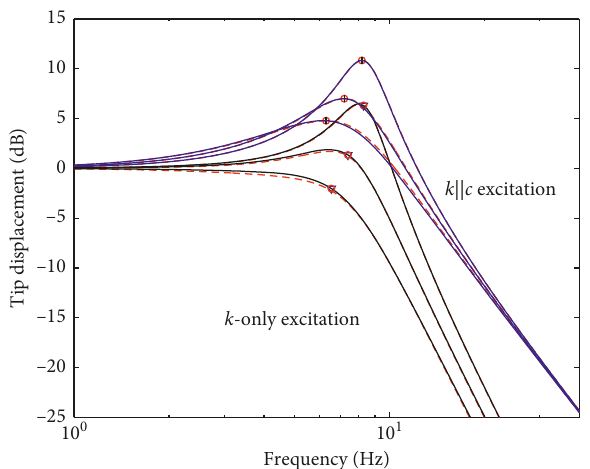
Figure 14: Optimal responses using the general design rule ω d ” (solid lines) and the standard design rule “ ω t “ ω t (cid:31) (dashed) for the two systems in Figure 13 in three different design cases given by Table 2. The symbols, “ at ω t , ω s , and ω d in successive